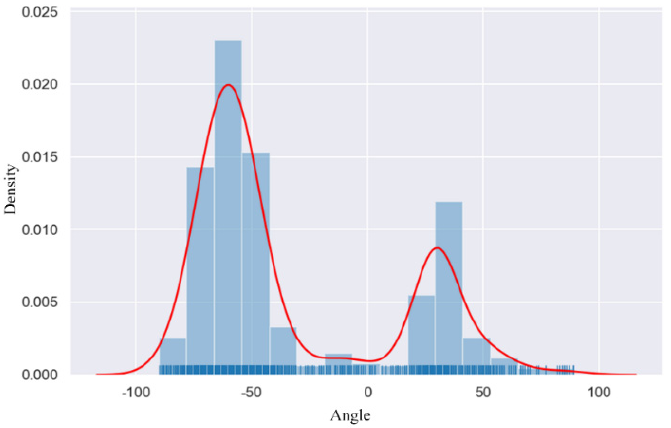
Figure 3. Probability density distribution of tilt angle in the insulator